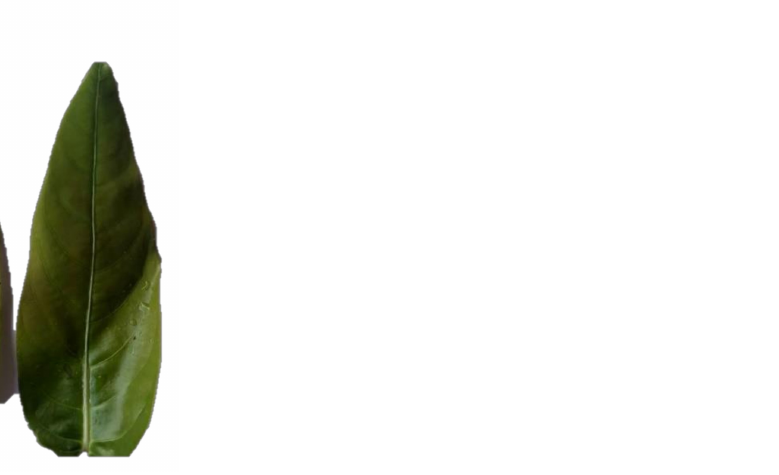
Figure 1. Leaves of Glochidion wallichianum Mull. Arg., commonly known as Mon-Pu (Thai name;